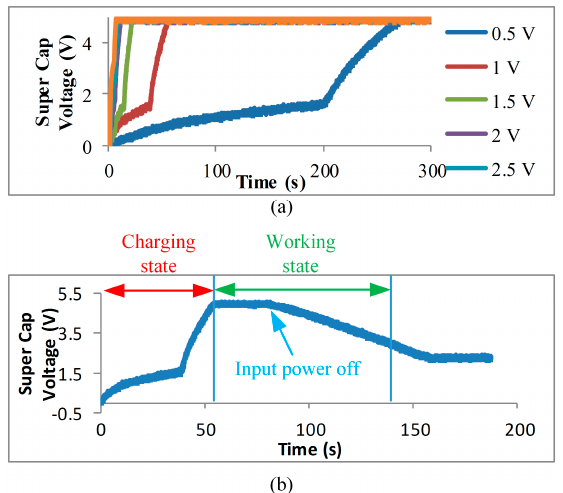
Figure 8. ( a ) The charge curve of sensing system with different input voltages; ( b ) The sensing system operation process.